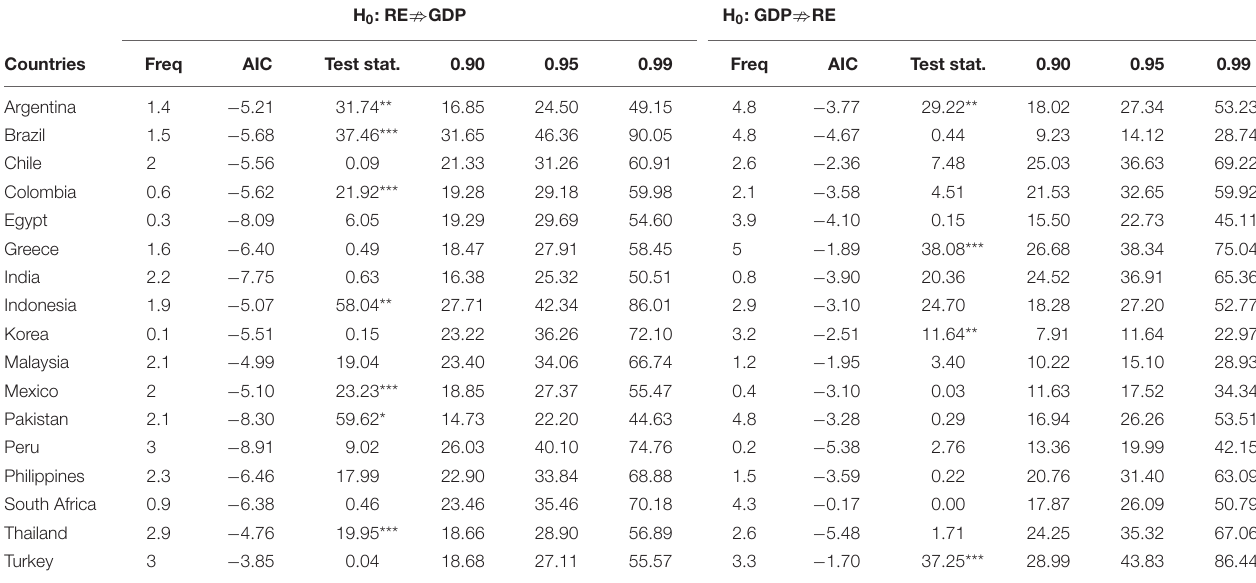
TABLE 5 | Fourier bootstrap panel causality test results for GDP-RE.